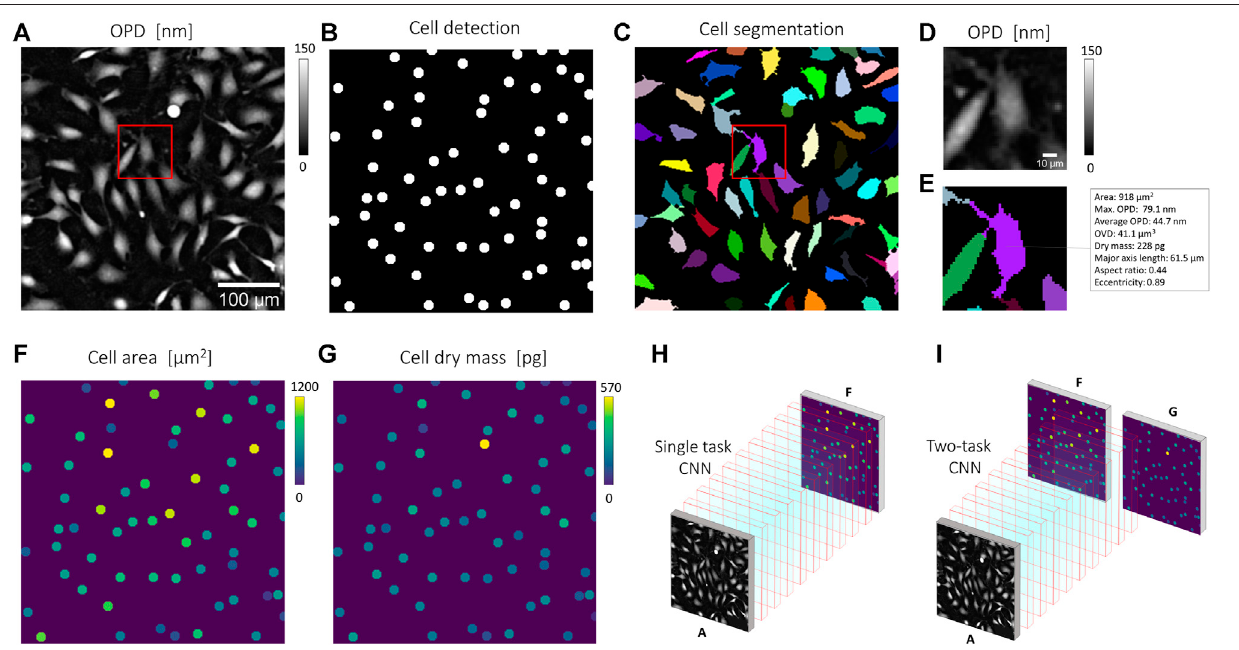
FIGURE 2 | Quantitative representation for CNN training. (B,C,E) Results of a standard imaging processing pipeline applied to (A) , a reconstructed OPD image of fi broblastcellsacquiredbylens-freemicroscopy. (B) CelldetectionobtainedwiththedetectionmoduleofFIJITrackMateplugin[18]. (C) Cellsegmentationobtainedwith aseededgrowingalgorithm. (D-E) Detailsoftheredboxin (C) showinganOPDmap (D) andcorrespondingcellmeasurementscalculatedforthecelldepictedinpurple (E) . The cell segmentation in (C) allows the calculation of the cell area, the cell dry mass ( Eq. 4 ). These measurements can next be translated into quantitative cell representations (F,G), where each cell is represented by a six-pixel (10 µm) diameter disc with pixel intensity corresponding to individual cell measurements. (H) A CNN can be trained to translate OPD map (A) into quantitative cell representation, here that of cell area (F) . (I) A CNN can be trained to predict multiple quantitative cell representations, here that of cell area (F) and cell dry mass (G)